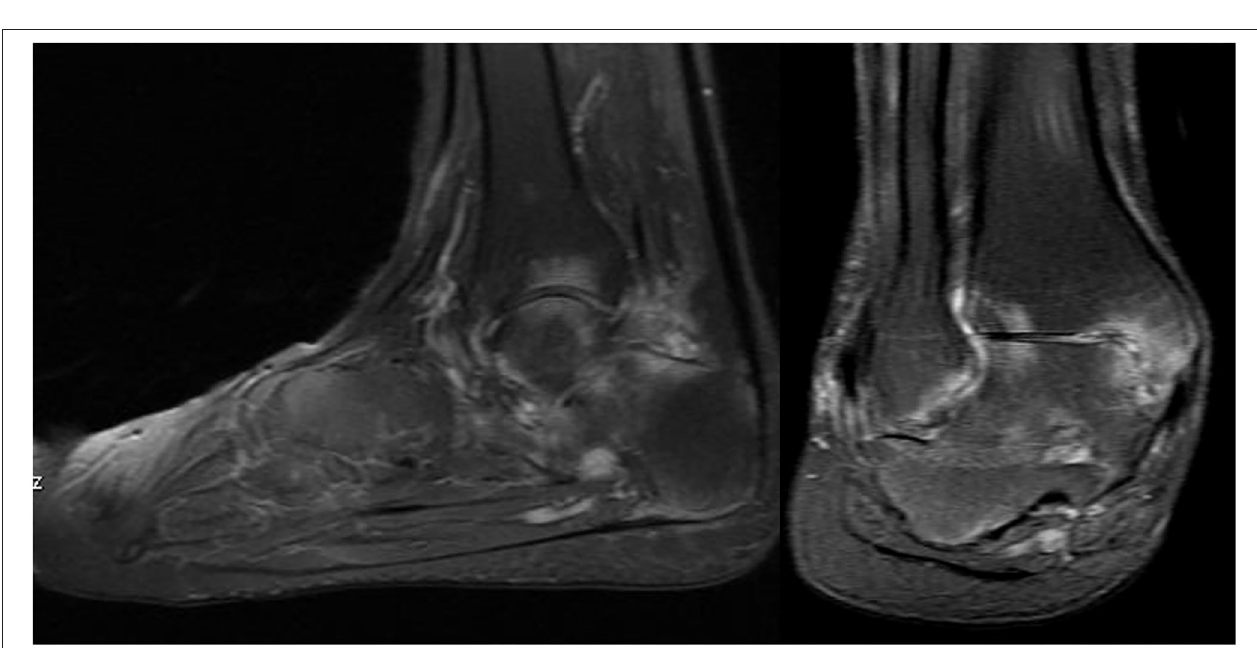
FIGURE 3 | T-2 weighted-fat suppressed MR imaging showing edema in various tarsal bones, joint spaces and soft tissues in a 16 year old boy with chronic ankylosing tarsitis [Modified from Burgos-Vargas (46)].